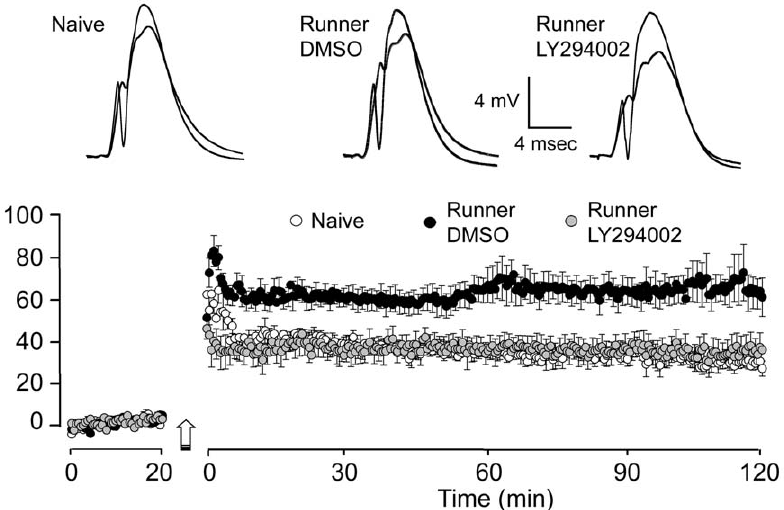
Figure 6. The effect of running on LTP in the dentate gyrus. The point plot represents the percent change in the EPSP recorded for 2 hours post tetanus (indicated by the arrow). Each point represent stimulated response every 30 sec with error bar on every second point. The mean of the last 15 minutes of recording showed 28.72 6 3.50% potentiation of the EPSP slope in naı¨ve control rats (Grey diamonds, n=8). In contrast, exercising rats infused with DMSO (Black circles, n=7) show over 64.84 6 9.13% potentiation of the EPSP. Exercising rats infused with the PI3K inhibitor, LY294004 (Open circles, n=7) show near identical potentiation of EPSP (33.26 6 6.69%) than that of naı¨ve rats. Above are representative field potentials recorded before and after LTP induction in the three groups.